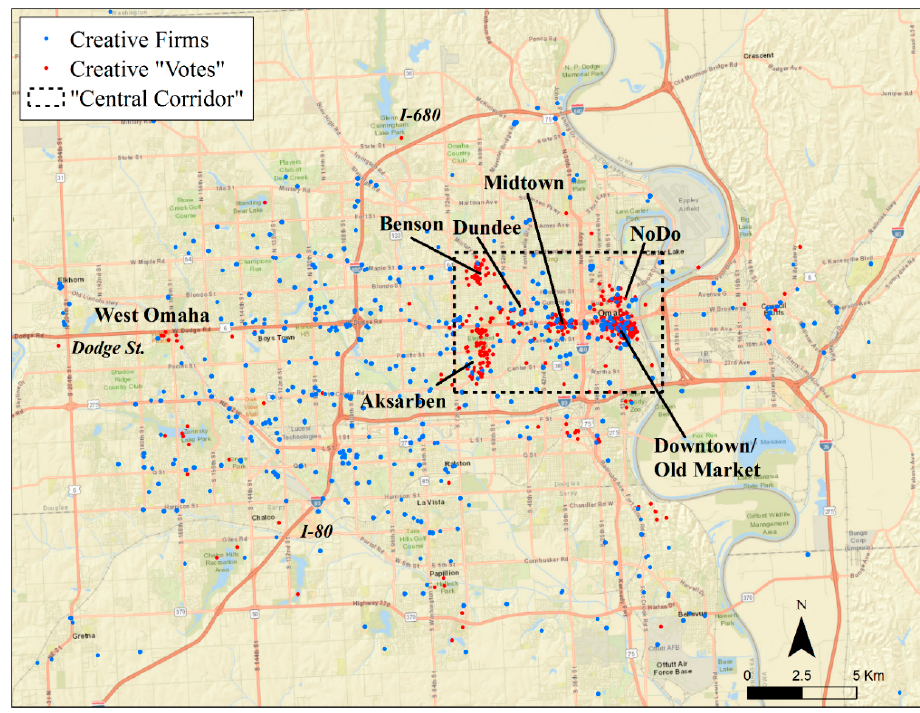
Figure 2. The location of creative firms and creative “votes” within the Omaha study area. Basemap courtesy of Esri™ [74].